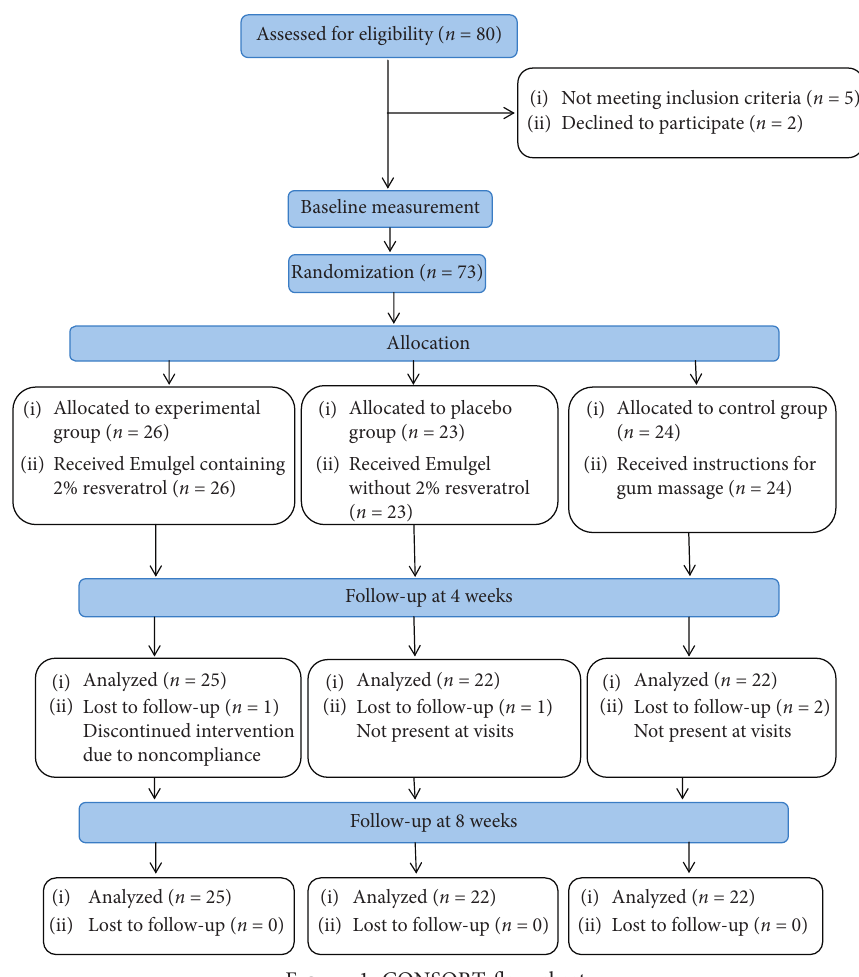
Figure 1: CONSORT flow chart. Table 1: Comparison of mean probing pocket depth (PPD) from T 0 to T 2 in control, placebo, and experimental groups (mean ±